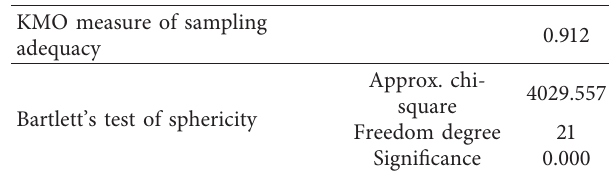
Table 3: KMO and Bartlett test.